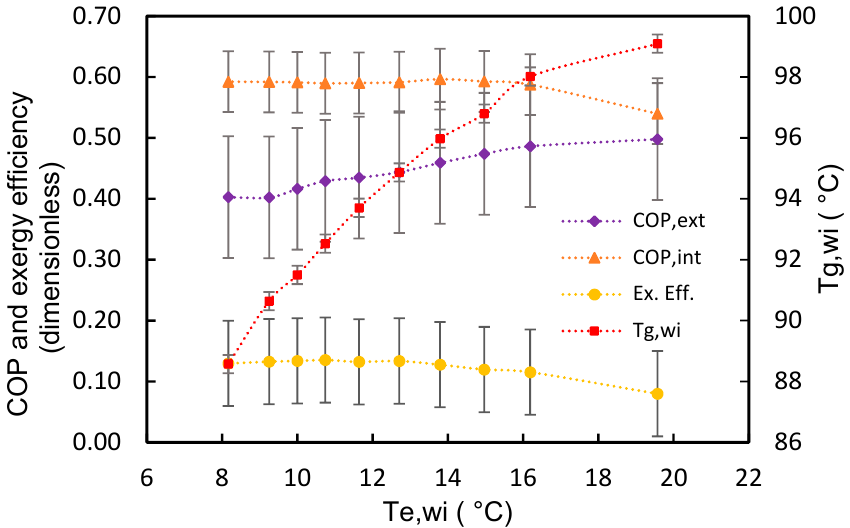
Figure 16. COP and exergy efficiency variation as a function of the change in the temperatures of the chilled and heating water.